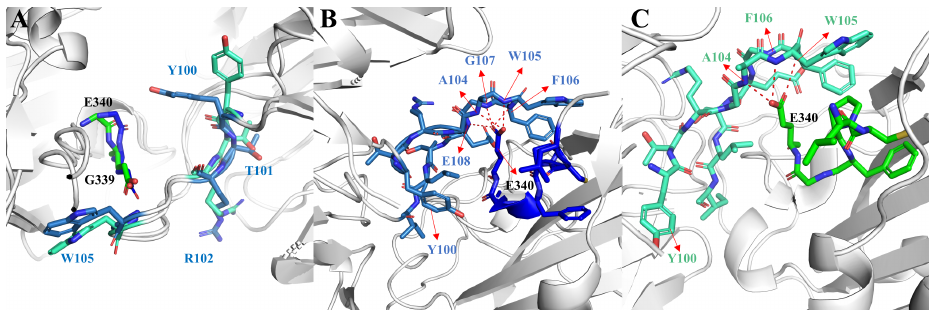
Figure 8. Changes in structure and hydrogen bond network of key residues in GLYCAN and NO- GLYCAN: ( A ) the structural difference of key residues located at the antigen–antibody interaction interface; ( B ) the hydrogen bond network between L335-E340 and CDR3 residues in the GLYCAN; ( C ) the hydrogen bond network between L335-E340 and CDR3 residues in the NO-GLYCAN; blue for GLYCAN antigen RBD; skyblue for CLYCAN antibody S309; green for NO-GLYCAN antigen RBD; blue-green for NO-GLYCAN antibody S309.